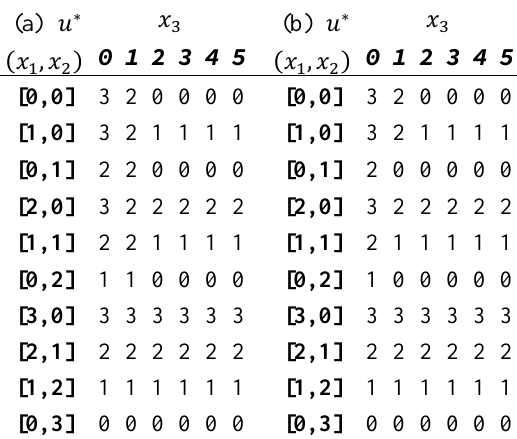
Table 4. Optimal production decisions s=3, K=0